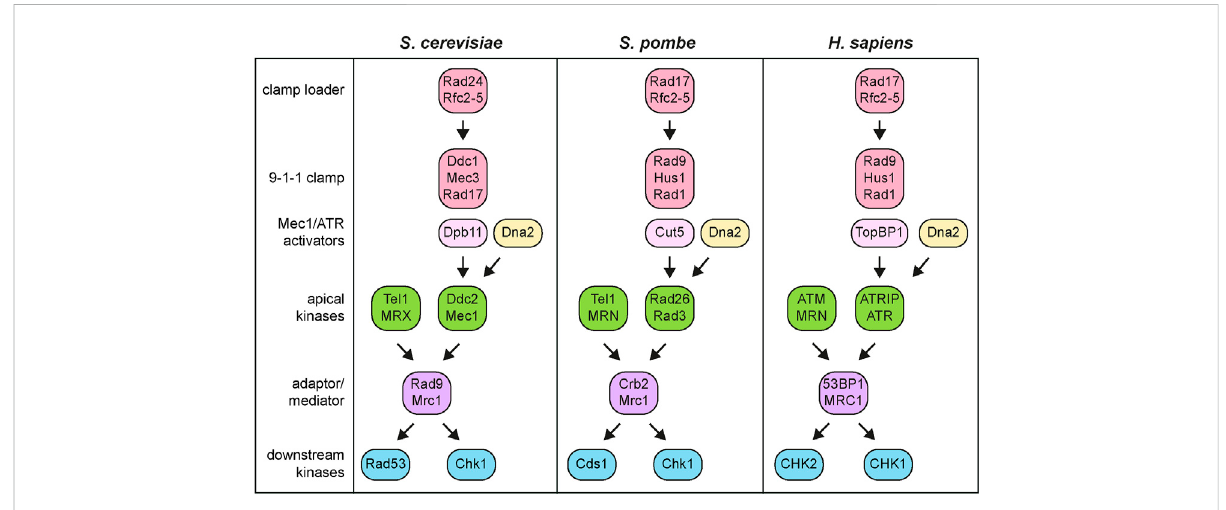
FIGURE 2 Simpli fi ed DNA damage checkpoint architecture in S. cerevisiae , S. pombe and H. sapiens . See text for